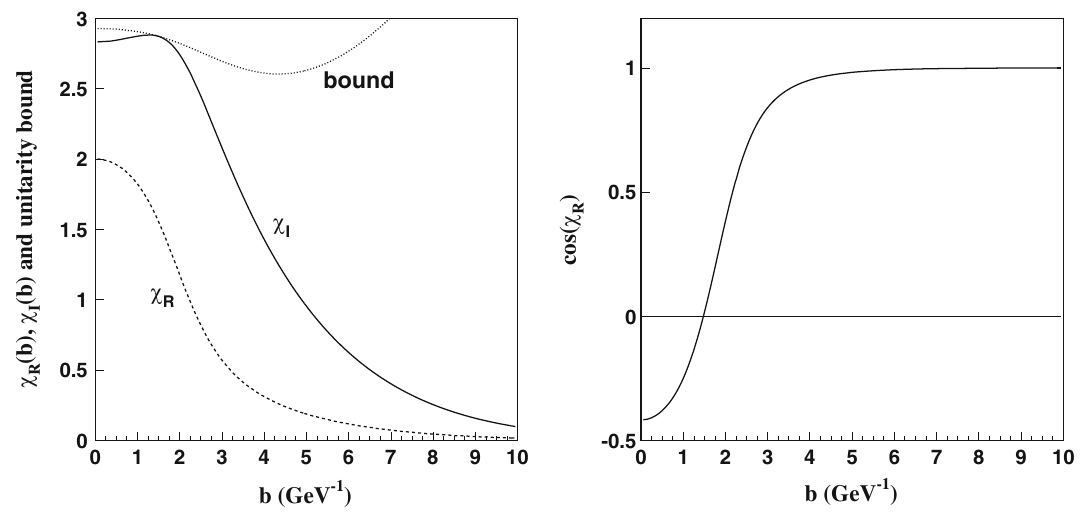
Fig. 9 Eikonal quantities. a The quantity bound ( b ) = − ( 1 / 2 ) log ( T 2 /π) shown with dotted line participates in the R constraint of Eq. (36); b χ R ( b ) is in the second quadrant for